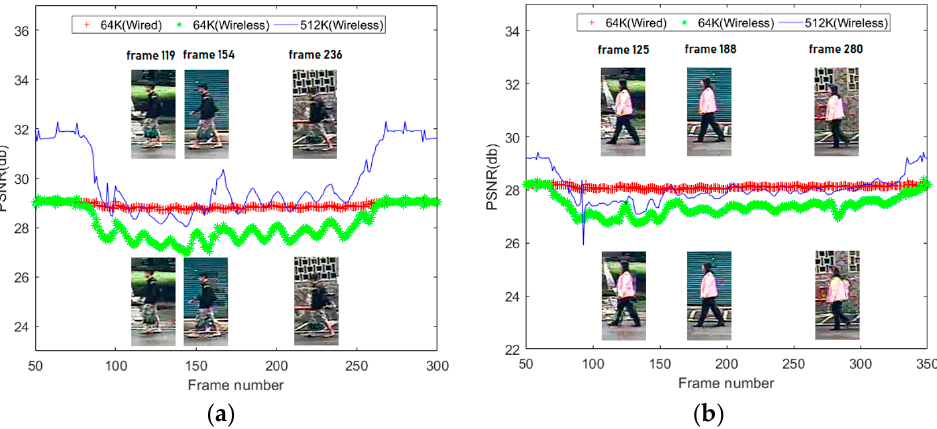
Figure 8 . ( a ) The red line (+) represents the PSNR value for coding at 64 Kbps without network transfer. The green line (*) represents the PSNR value for coding at 64 Kbps transferred through the network environment. The blue line ( − ) represents the estimated PSNR value for a 512 Kbps coding bitrate transferred by the network environment. As shown in the figure, the blue line is closer than the green line to the red line. It is clear that frames 119, 154, and 236 show a better image quality. ( b ) Another set of the moving objects. Similarly, the result shows that the moving objects at the frame 125, 188, and 280 positions have better image quality except that their moving speed is slower.